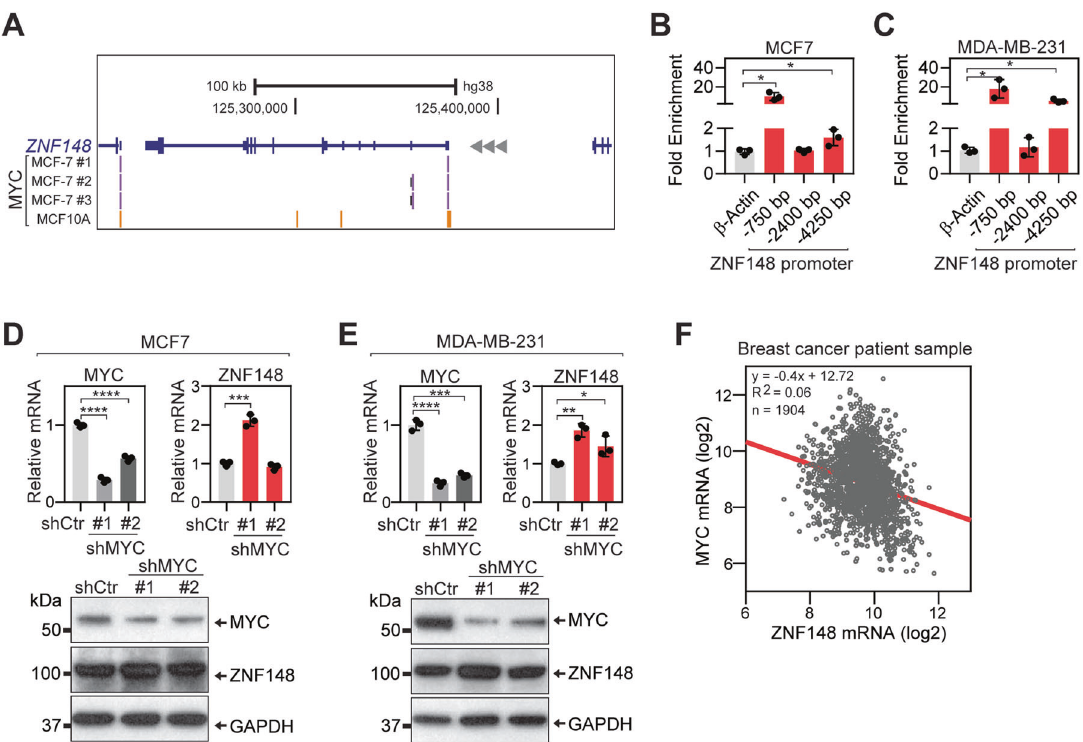
Fig. 1 MYC represses ZNF148 expression by direct chromatin occupancy. A Schematic representation of ZNF148 locus on chromosome 3q21 reverse strand. Peak calls for MYC in MCF7 (purple bars), and MCF10A (yellow bars) cells from ENCODE [47] are indicated. B Quantitative ChIP-PCR (ChIP-qPCR) validation of MYC occupancy at − 750, − 2400, and − 4250 bp upstream of ZNF148 promoter region in MCF7 cells ( n = 3). C As in “ B ” for MDA-MB-231 cells. D Analysis of MYC and ZNF148 mRNA and protein in MCF7 cells transduced with the short-hairpin (sh) luciferase control (Ctr) and shMYC #1 and #2 lentiviruses, by RT-qPCR (top panel, n = 3) and Western blot (bottom panel). E As in “ C ” for MDA-MB-231 cells. F Scatter plot of MYC and ZNF148 mRNA levels (log2) from 1904 breast cancer patient samples in METABRIC cohort [56, 78]. Spearman correlations of − 0.24 ( p = 5.29 − 27 ) and Pearson correlations of − 0.25 ( p = 1.90 − 27 ) indicate an inverse correlation of ZNF148 and MYC mRNA levels and is depicted with a linear trend line in “ red ” . Student ’ s t-test, * P < 0.05. ** P < 0.01. *** P < 0.001. **** P < 0.0001. Error bars indicate mean ±